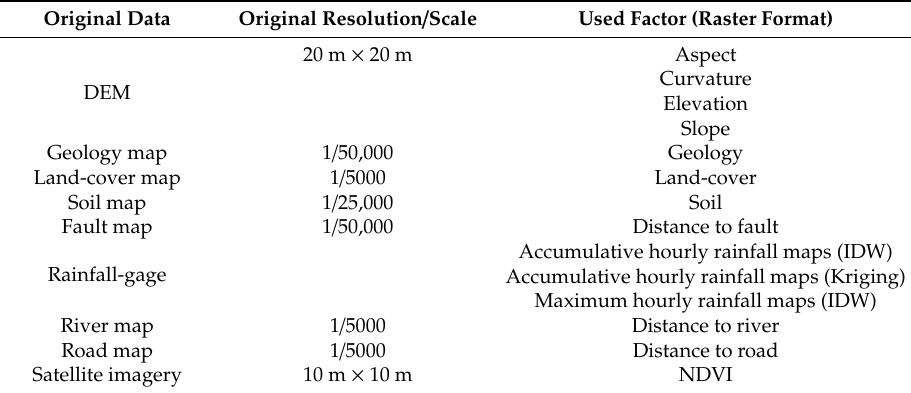
Table 2. Landslide factors used in the